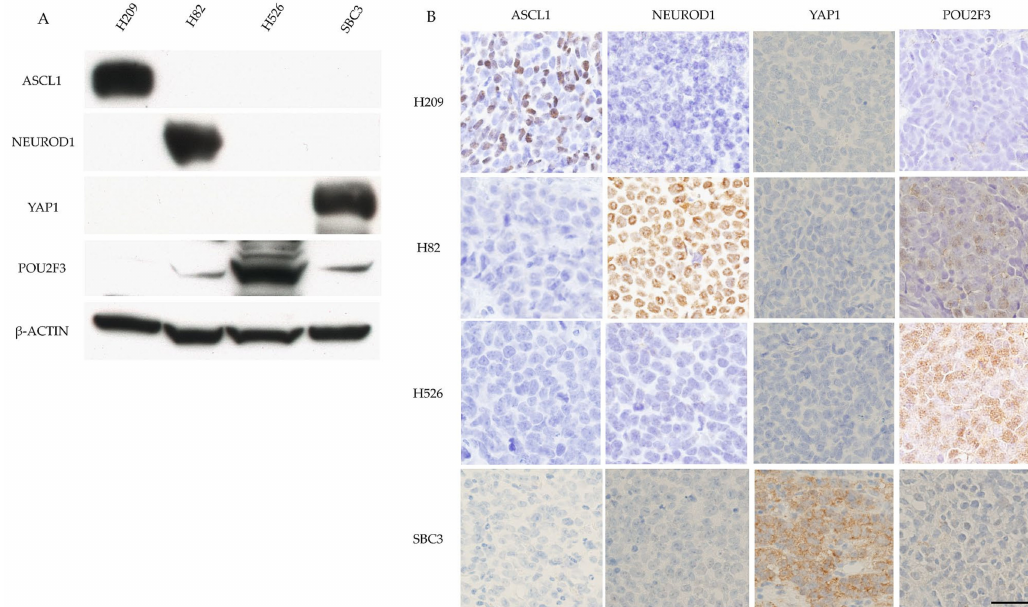
Figure 1. Example of the positive control of four key molecules by WB and IHC in SCLC samples. ( A ) Example of the positive control of the four key molecules by WB in SCLC cell lines. ASCL1 was strongly expressed in H209 cells. NeuroD1 was strongly expressed in H82 cells. Pou2F3 was strongly expressed in H526 cells and weakly expressed in H82 and SBC3 cells. YAP1 was strongly expressed in SBC3 cells. β -actin served as an internal control. ( B ) Example of the positive control of the four key molecules in xenotransplanted tumor tissues from the four cell lines in mice by IHC. ASCL1 staining was found in tumor cell nuclei of H209 cells. NeuroD1 staining was found in the tumor cell nuclei of H82 cells. Pou2F3 staining with a di ff use cytoplasmic pattern was found in H82, H526, and SBC3 cells. The Pou2F3 staining intensity was weak in H82 and SBC3 cells and strong in H526 cells. YAP1 was stained with a membranous pattern in SBC3 cells. Scale bar = 50 µ